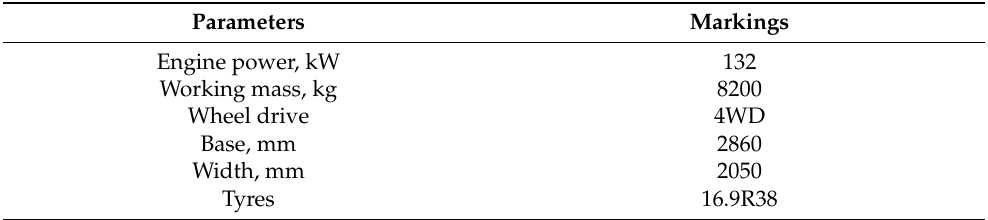
Table 1. Technical specification of the aggregation tractor unit KhTZ-16131 [24,25]. Parameters